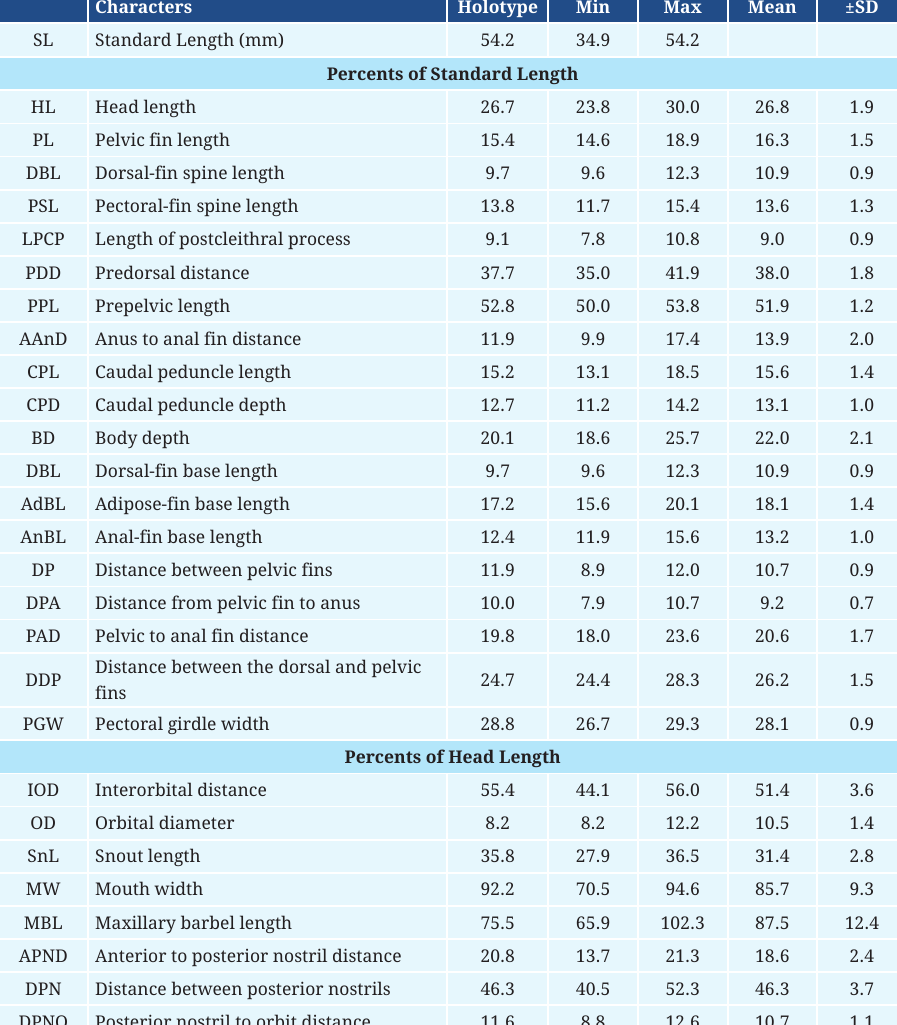
TABLE 1 | Morphometric data of best-preserved specimens of Microglanis berbixae , expressed as percentages of standard length and percentages of head length, n = 13 (SD: standard deviation) (range and SD include